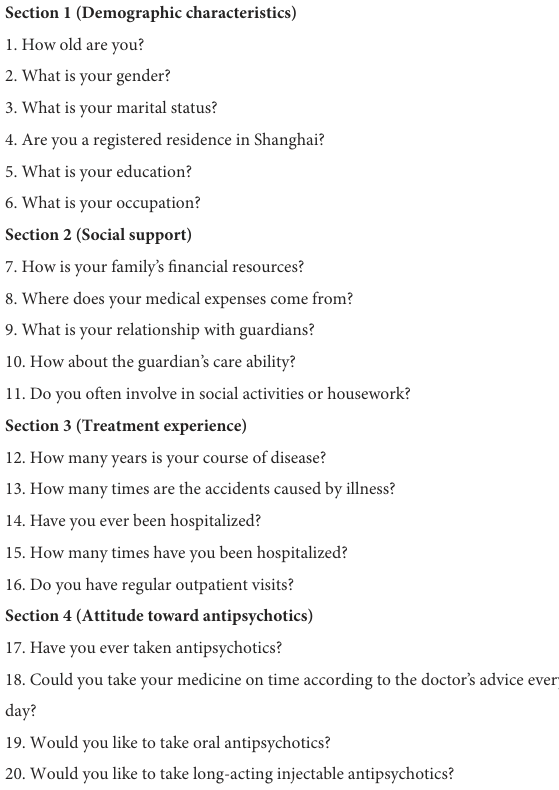
Section 1 (Demographic